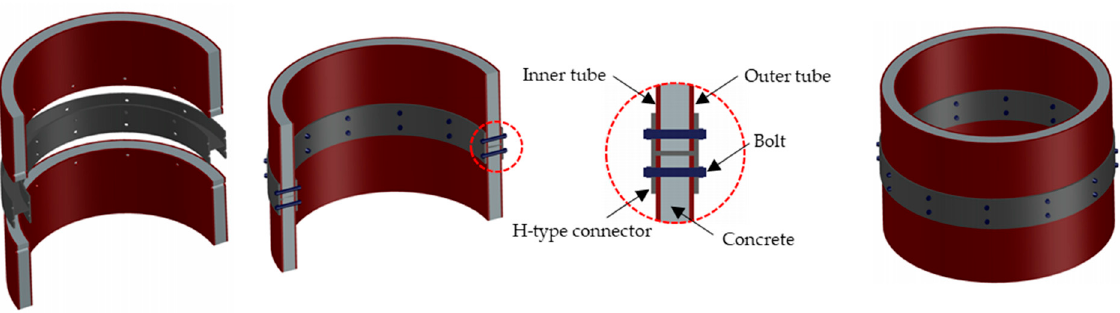
Figure 6. H-type connector (Type-H).